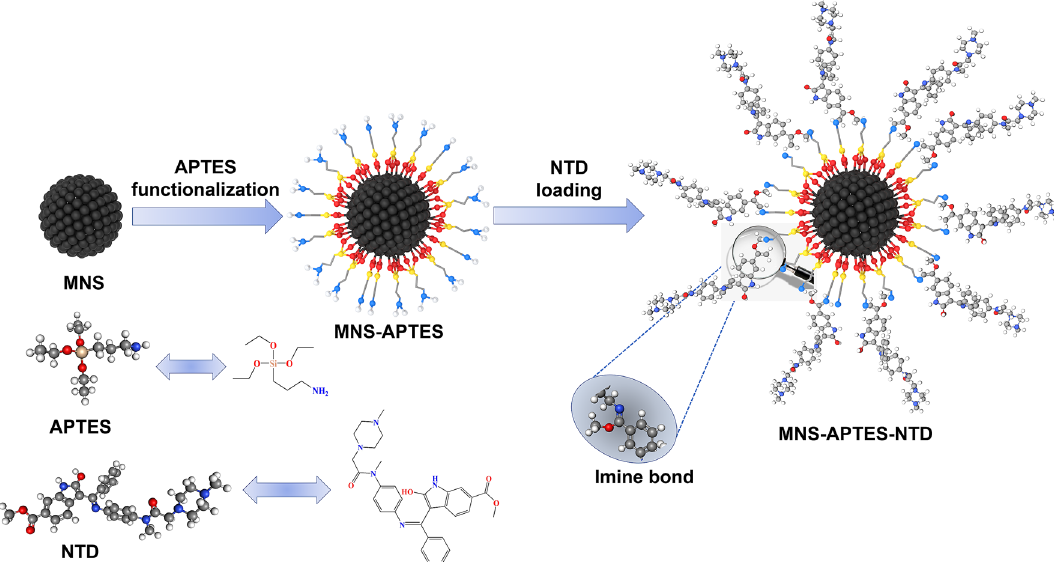
Scheme 1. Schematic representation of the surface modification and loading of the drug over the MNS